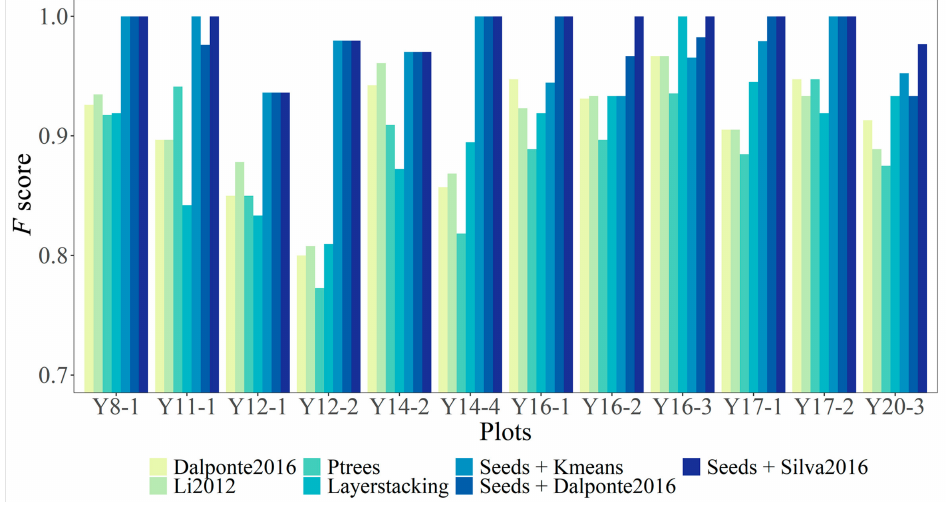
Figure 9. The accuracy tested by F score for all seven individual tree segmentation (ITS) methods. Table 5. The summarized accuracy for all seven individual tree segmentation (ITS)